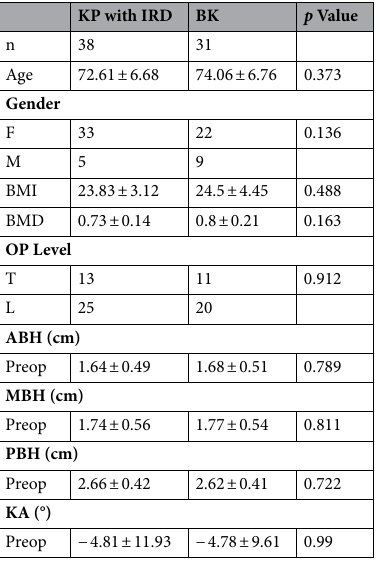
Table 1. Patient Characteristics and Preoperative radiological data. ABH anterior body height, BMD bone marrow density, BMI body mass index, KA kyphotic angle, MBH middle body height, PBH posterior body height, Preop preoperative.